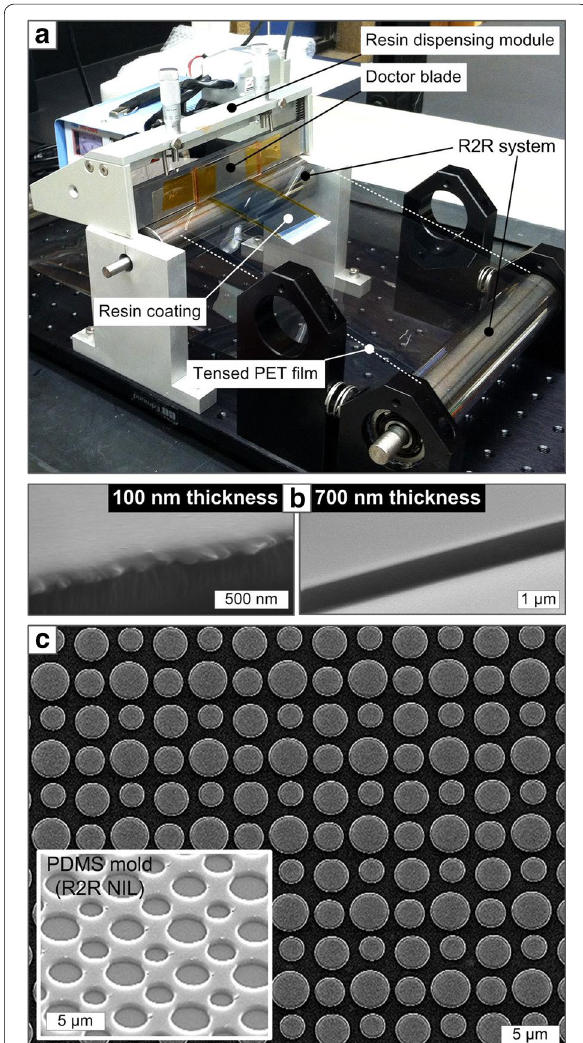
Fig. 4 Doctor blade coating for rapid and scalable thin film fabrication and its nanopatterning application. a Optical image